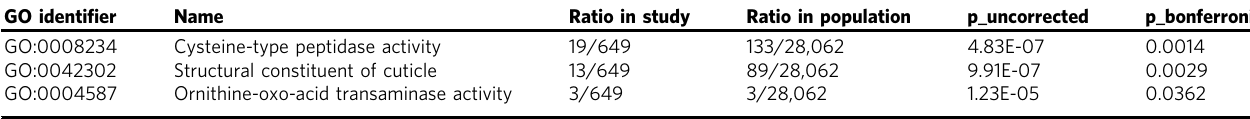
Table 4 GO terms enriched in H. mephisto genes downregulated under heat stress GO identi fi